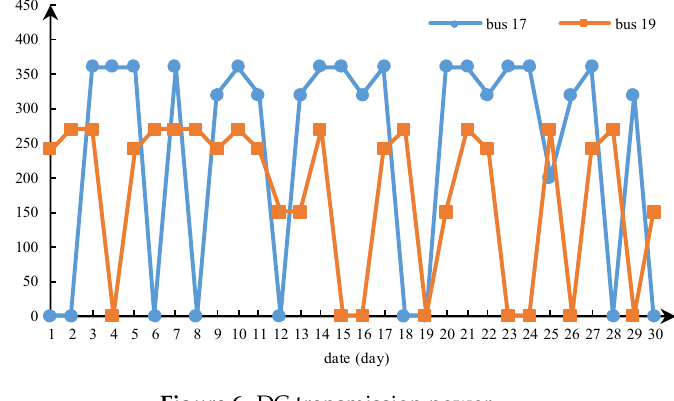
Table 3. Information of transformers to be maintained.